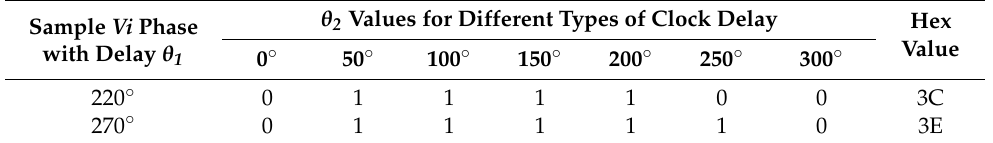
Table 1. Sample aging detection process.